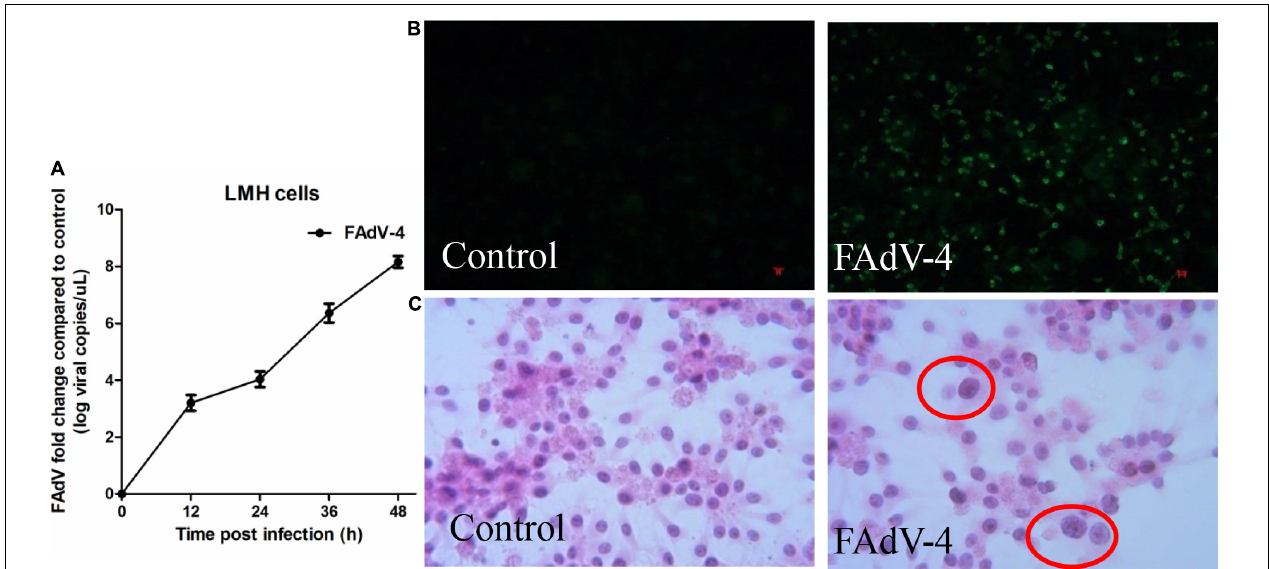
FIGURE 1 | Characteristics of FAdV-4 infected LMH cells. (A) The replication characteristics of the virus in LMH cells were determined by qRT-PCR. 50% of the cells were infected with FAdV-4 at 24 hpi by indirect immunofluorescence (B) , and viral inclusion bodies were observed in LMH cells (hematoxylin and eosin staining; × 400) (C)